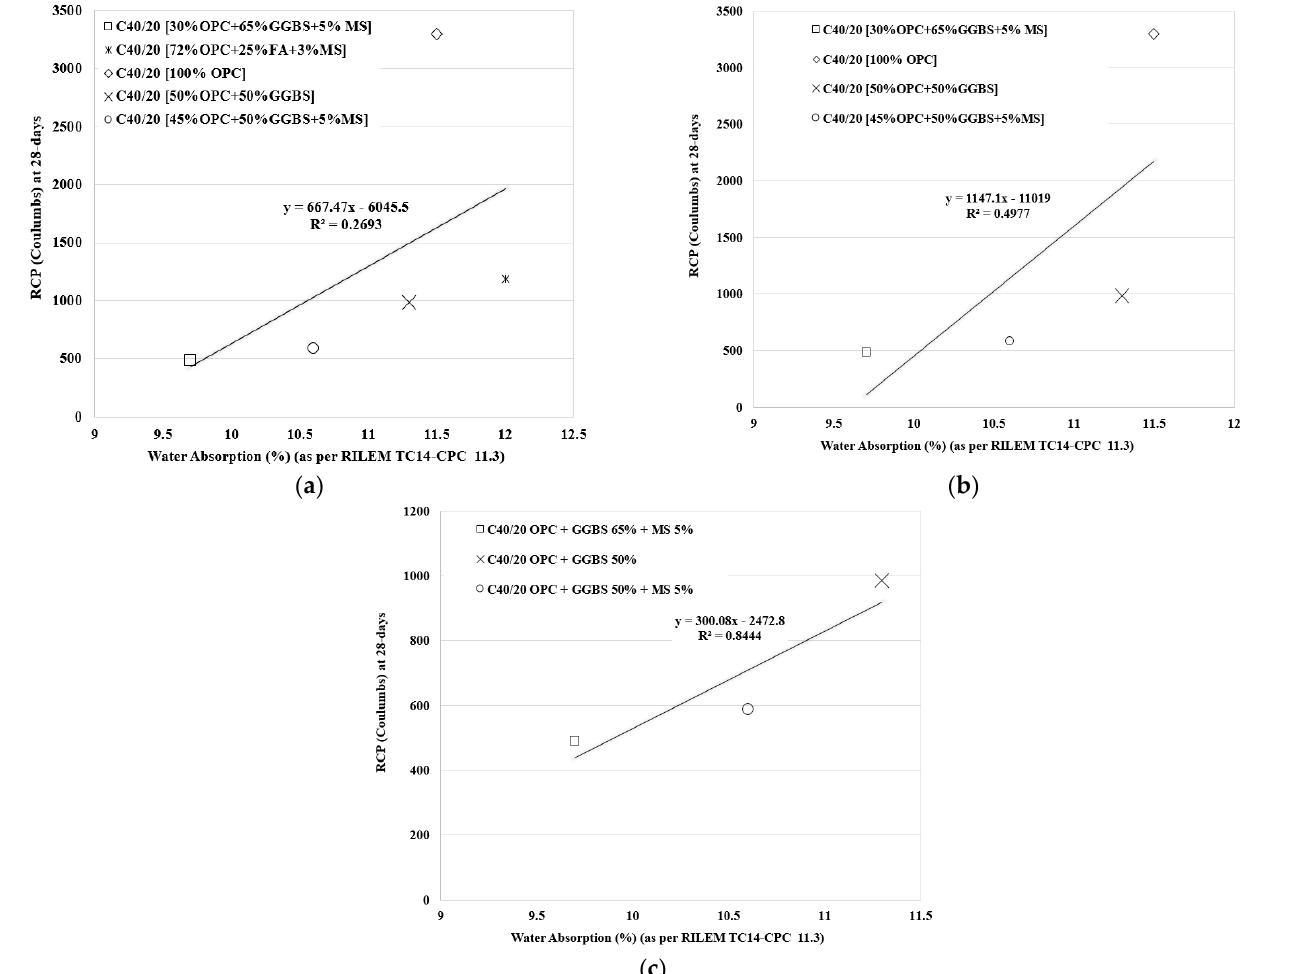
Figure 8. Linear correlation between porosity values obtained as per RILEM 11.3 and RCP ratings: ( a ) all investigated mixes; ( b ) OPC and GGBS mixes; and ( c ) GGBS mixtures only.